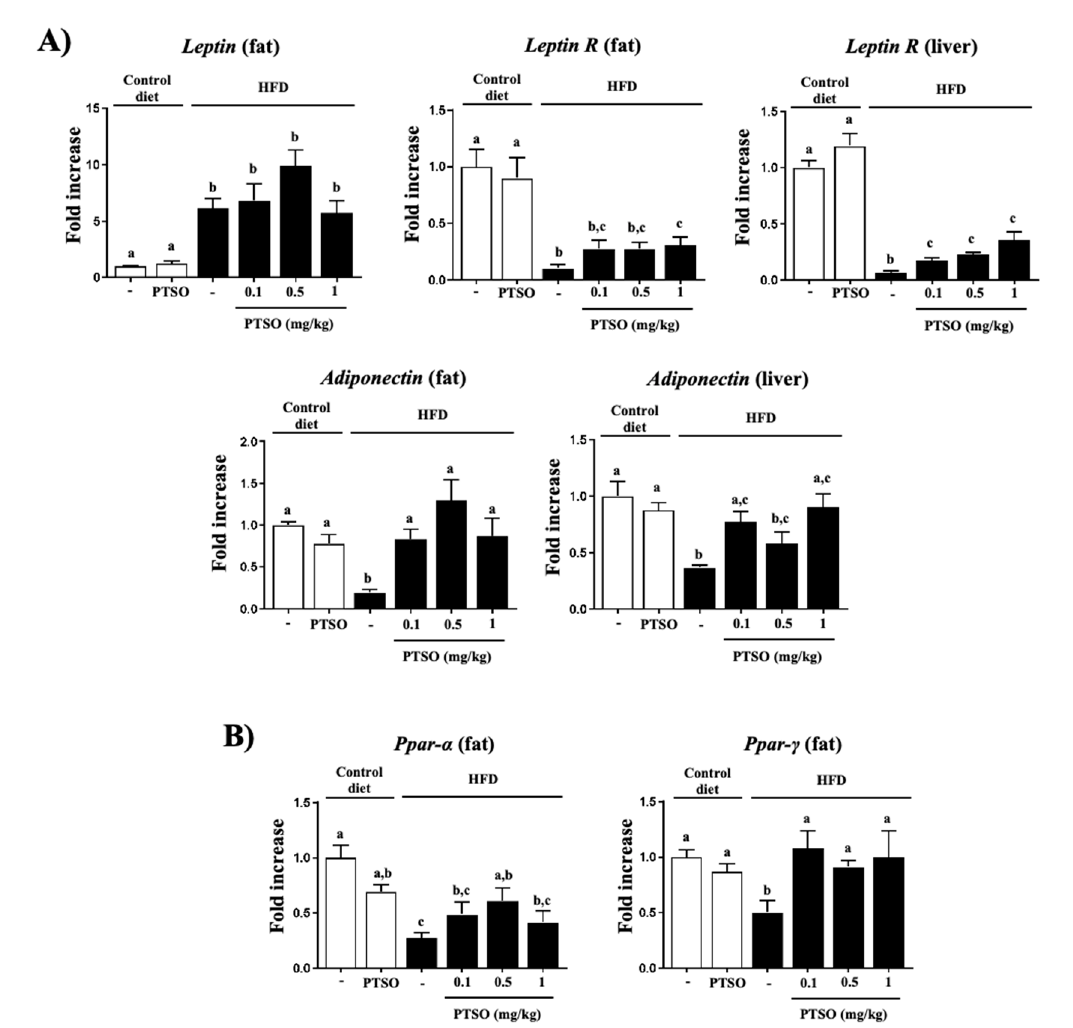
Figure 4. Effects of propyl propane thiosulfonate (PTSO) administration on ( A ) Leptin , Leptin R and Adiponectin expression in the liver and fat and ( B ) on fat and liver gene expression of, Ppar- α and Ppar- γ in control and high-fat diet (HFD)-fed mice. Analysis performed by real-time qPCR. Groups with different letters statistically differed ( p < 0.05).